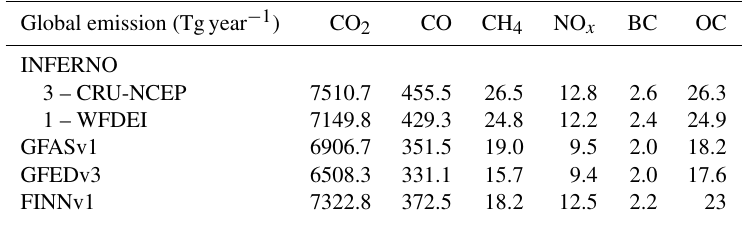
Table 3. Average annual emission (Tgyear − 1 ) for INFERNO with the interactive ignition mode and CRU-NCEP reanalysis (3 – CRU-NCEP) and the constant ignition mode and WFDEI reanalysis (1 – WFDEI), comparison to GFASv1 (Kaiser et al., 2012), GFEDv3 (van der Werf et al., 2010) and FINNv1 (Wiedinmyer et al., 2011) is provided.